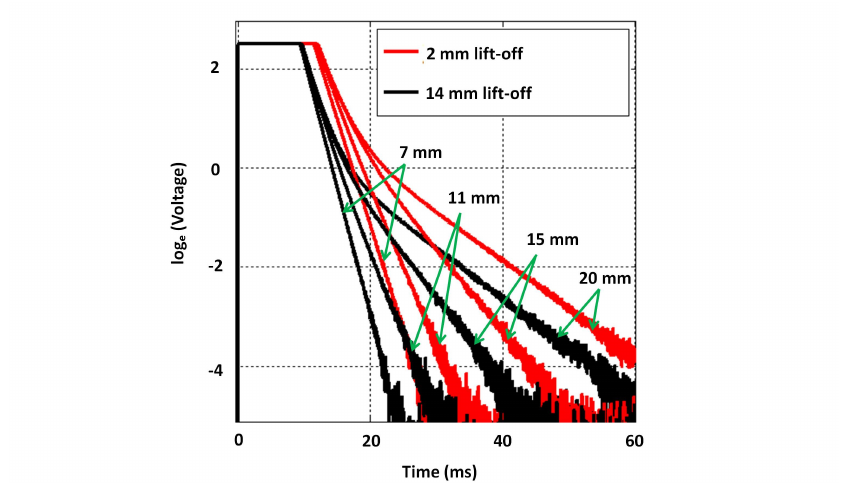
Figure 15. Influence of lift-off on signals across the full thickness range; sharp rising edges of signals are not discriminable in the ms time scale and appear to be